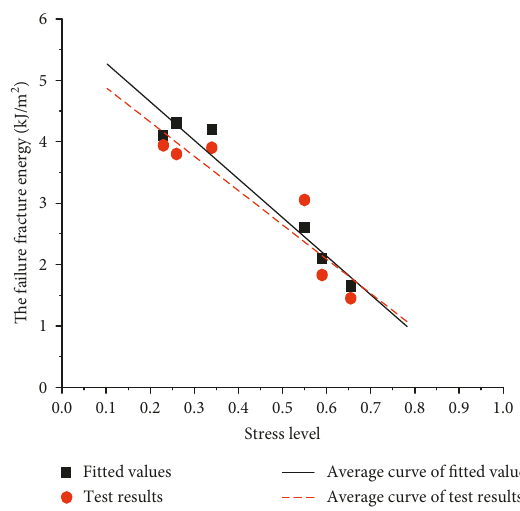
Figure 11: Comparison of J IF results obtained from J R resistance curves and experimental P -CMOD curves.